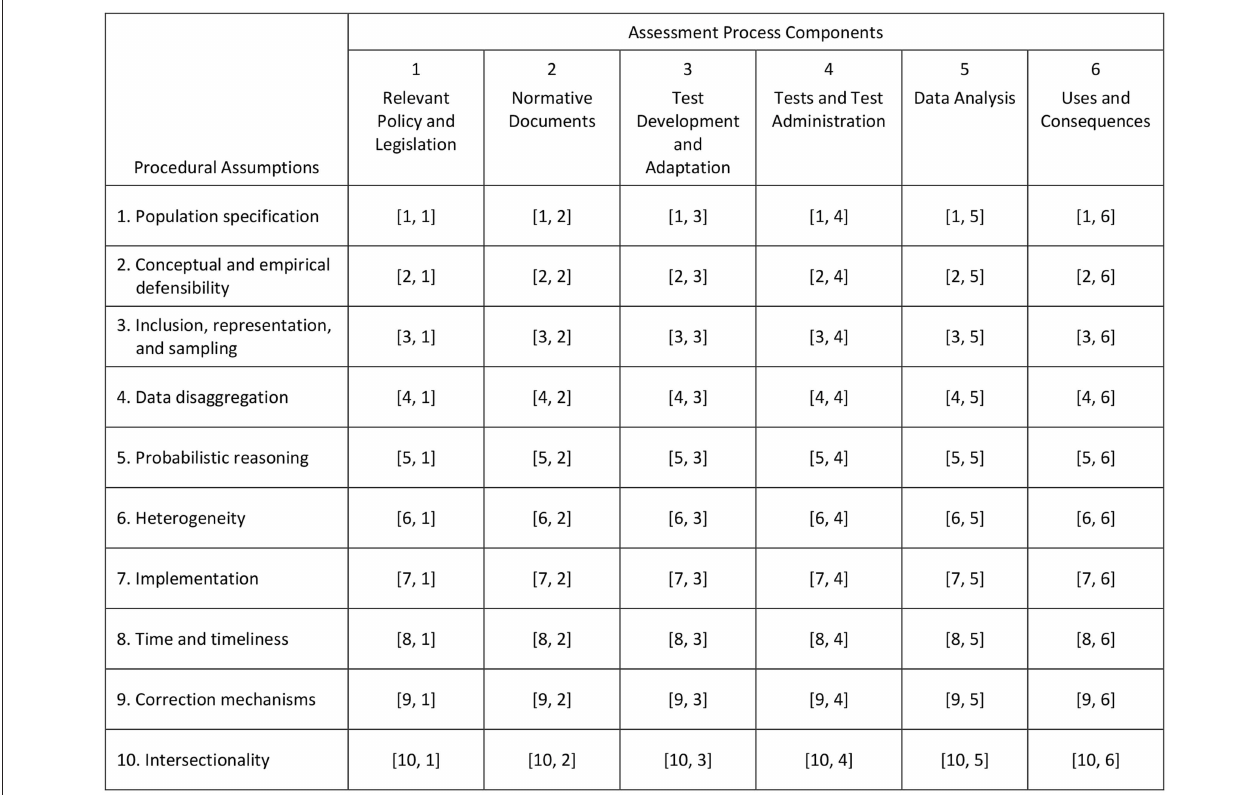
FIGURE 2 | Matrix of evidence for validity argumentation with a specific set of procedural assumptions and a specific set of assessment process